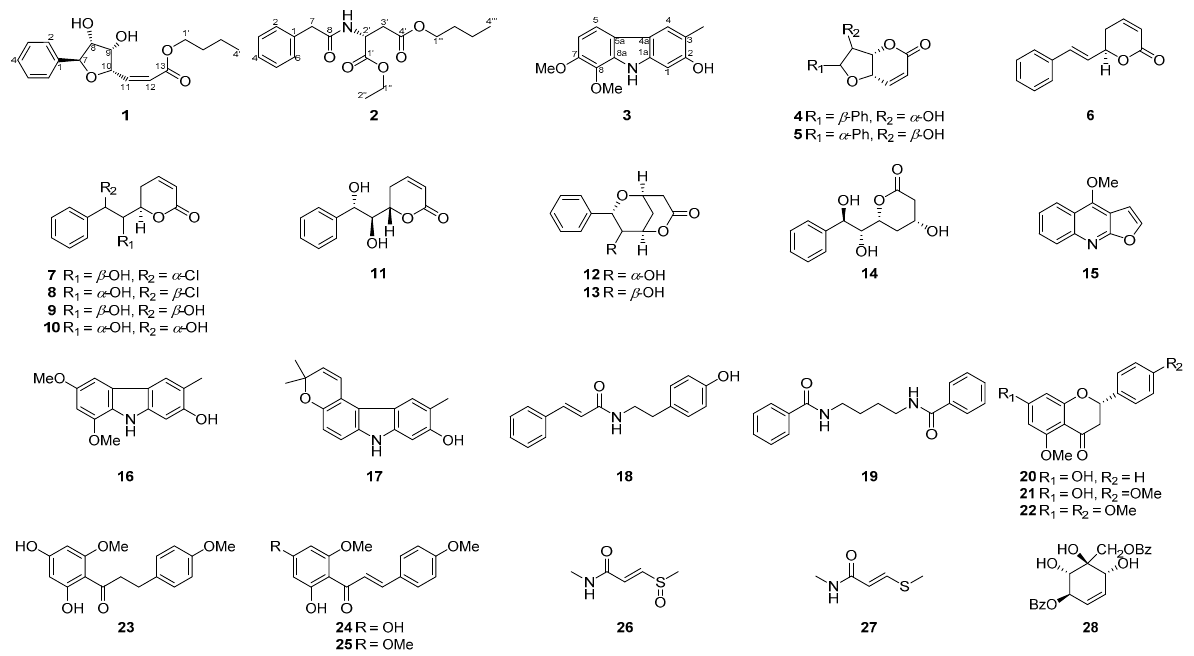
Figure 1. Structures of compounds 1 ‒ 28 .